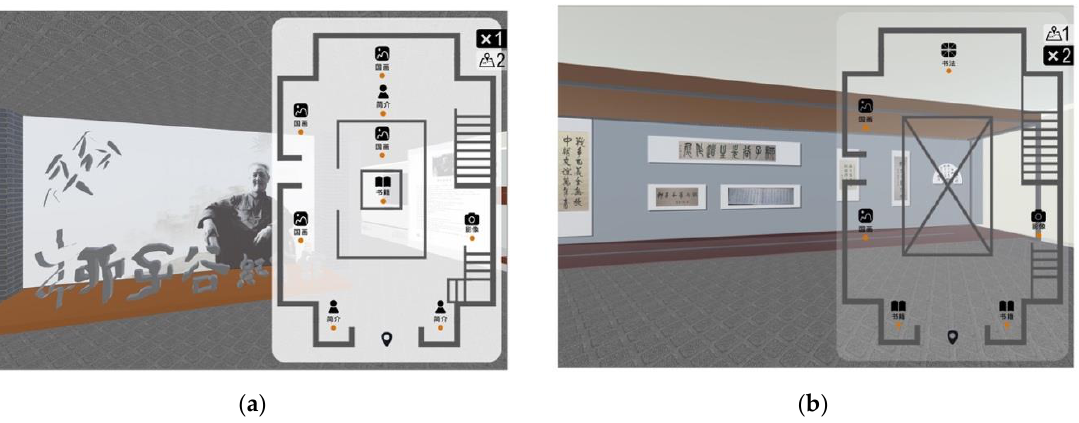
Figure 2. Examples of the virtual museum interfaces: ( a ) the 1/2 screen-size 20% transparent overview map of the ground floor; ( b ) the 1/2 screen-size 80% transparent overview map of the second floor. 简 介 : Introduction; 国 画 : Traditional Chinese Painting; 书 籍 : Books; 影 像 : Image; 书 法 : Chinese